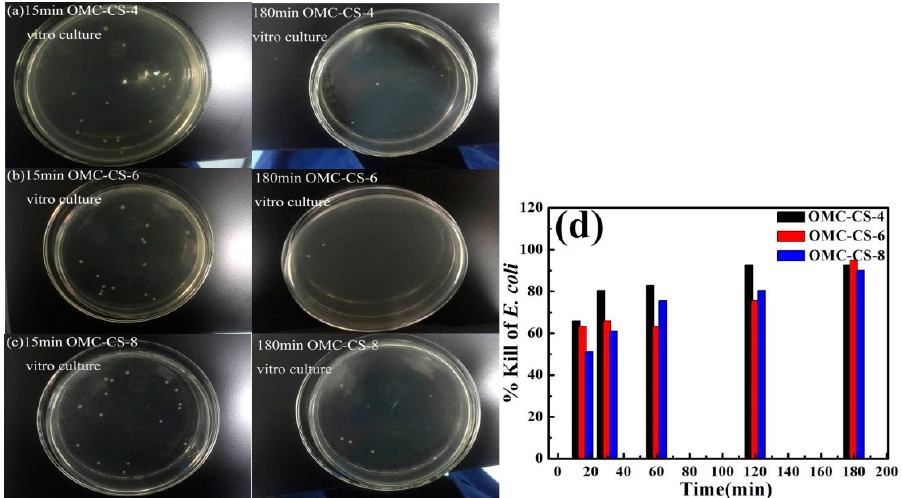
Figure 8. ( a–c ) The colony forming units; ( d ) Killing rate of microbes after vitro culture with OMC-CS-4,6,8 (100 µ g mL − 1 ) for 15, 30, 60, 120, 180 min at 10 6 CFU mL − 1 .